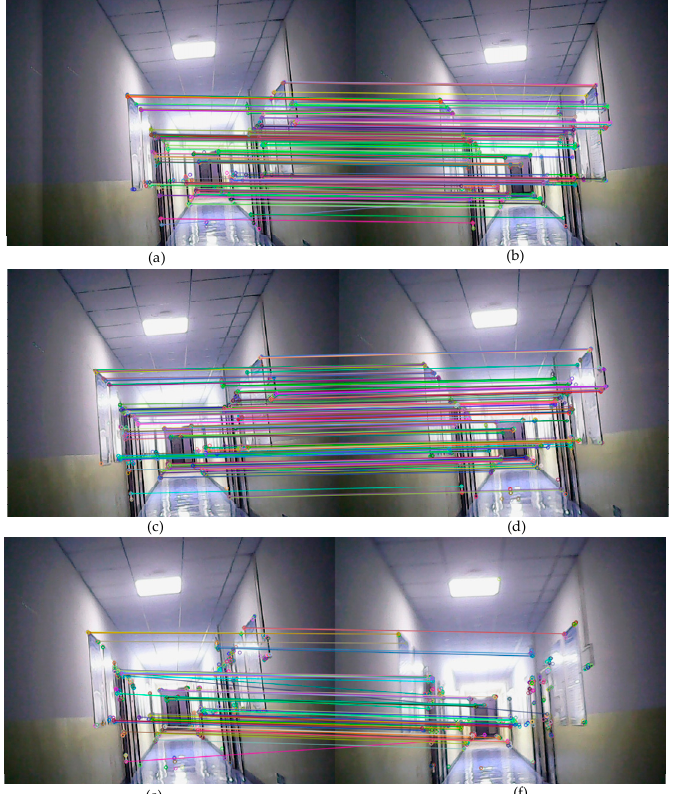
Figure 6. The matching corridor and corridor characteristic points. ( a ) First frame picture, ( b ) Sec- ond frame picture, ( c ) Third frame picture, ( d ) Fourth frame picture, ( e ) Fifth frame picture, ( f ) Sixth frame picture.